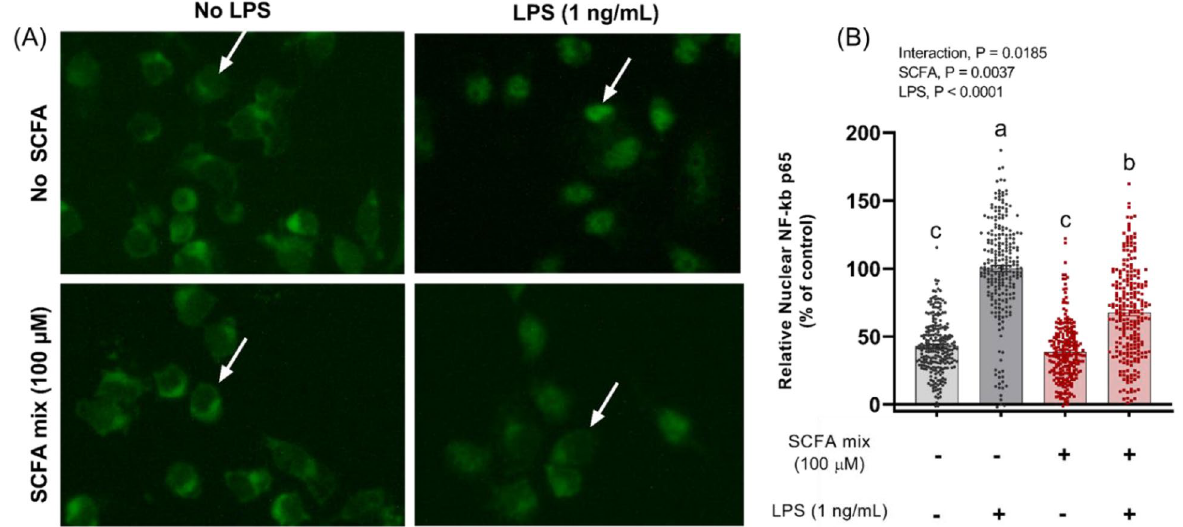
Figure 5. Effect of short-chain fatty acids on nuclear translocation of p65 NF-κB in primary microglia from adult mice 30 min after stimulation with LPS. (Panel A ) Fluorescence microscopy depicting immunocytochemical localization of NF-κB p65 (green) in primary microglia treated with no SCFA or SCFA mix (100 µM acetate + 100 µM butyrate) with no stimulation (two pictures on the left) and LPS 1 ng/mL stimulation (two pictures on the right). The white arrows point to the nucleus, indicating an example of the intensity of nuclear NF-κB in each treatment. (Panel B ) Relative Nuclear p65 NF-kB of primary microglia, expressed as percentage of control (cells stimulated with LPS and no SCFA treatment). Primary microglia were plated and pre-treated with 0 or 100 µM acetate and butyrate for 4 h. After 30 min of LPS stimulation (0 or 1 ng/ mL), cells were fixed and stained for p65 NF-κB. Values were expressed as the mean of four replicates, whose means resulted from 20 cells from three independent fields of view. Samples were analyzed by 2-way ANOVA (2 × 2 factorial arrangement of SCFA mix x LPS), followed by Šidák multiple comparisons test. Different lowercase letters are statistically different ( P < 0.05) among